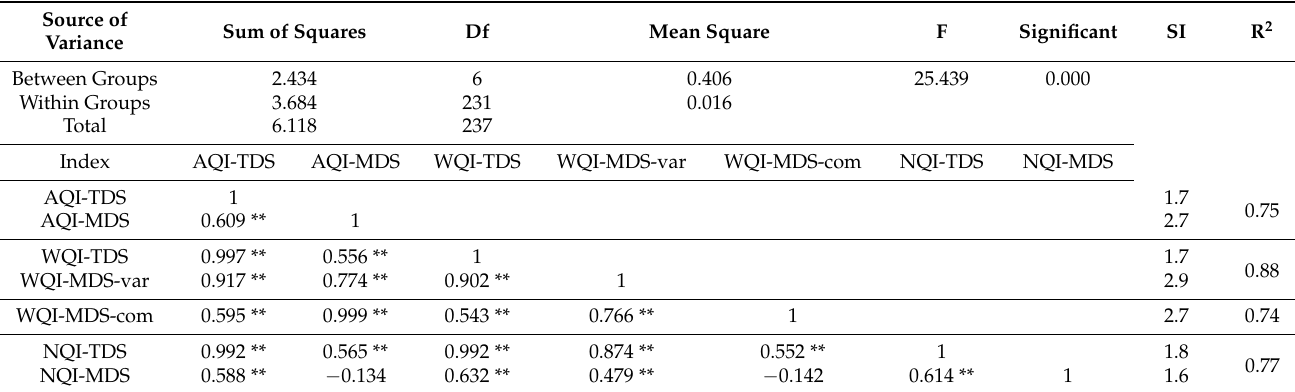
Table 7. Results of analysis of variance (ANOVA), Pearson correlations, sensitivity analysis, and the linear regression coefficients (R 2 ) for soil quality